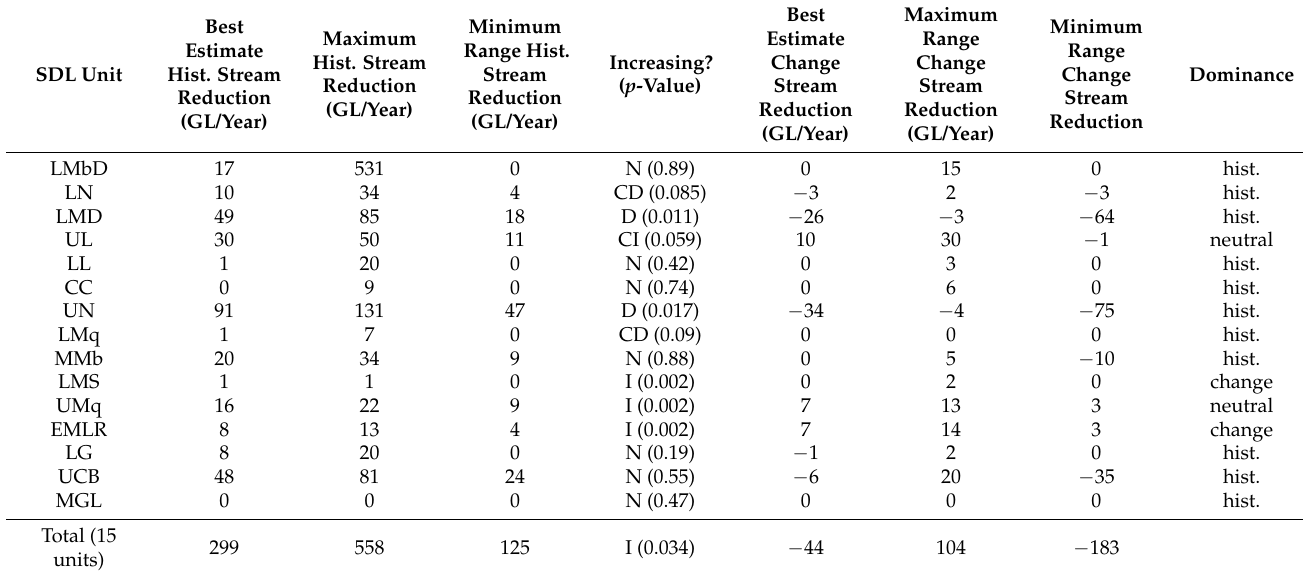
Table 4. Impacts of extraction for non-Victorian units, showing best estimate and range of impact from historical extraction and for the change in extraction. In the column ‘Increasing?’, N denotes neutral, I increasing, CI conditionally decreasing, D increasing, and CD conditionally decreasing, and the value in brackets is the p -value associated with the rate of increase; while under the column dominance, N denotes neutral, hist denotes impact dominated by historical extraction, and change denotes impact dominated by the change in extraction.